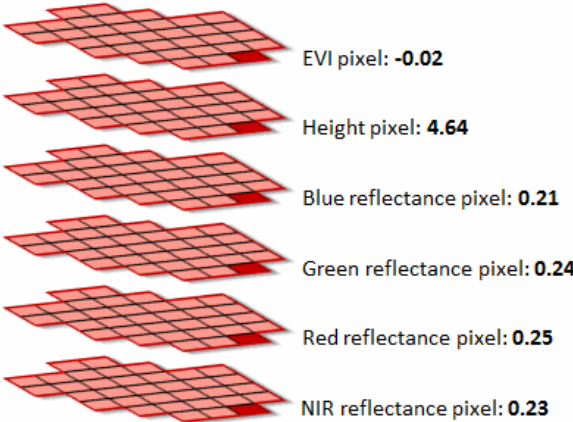
Figure 5. Example of the pixel values for six attributes in one ROI polygon using the building class.